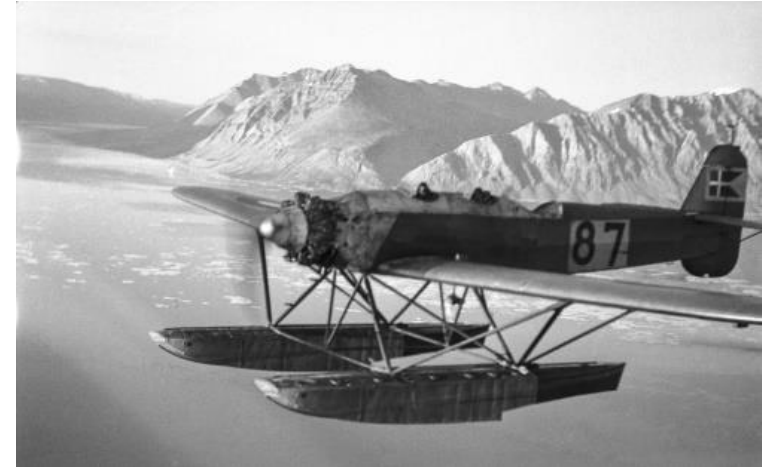
Figure 9. The Heinkel seaplane with open cockpit for three persons (pilot, radio-operator, and photographer in the back (photo: the Arctic Institute, https://arktiskinstitut.dk). The taking of the photos was carried out from a height of up to 4500 m at a temperature of −40 degrees Celsius frequently. Nowadays, these conditions are hardly imaginable.